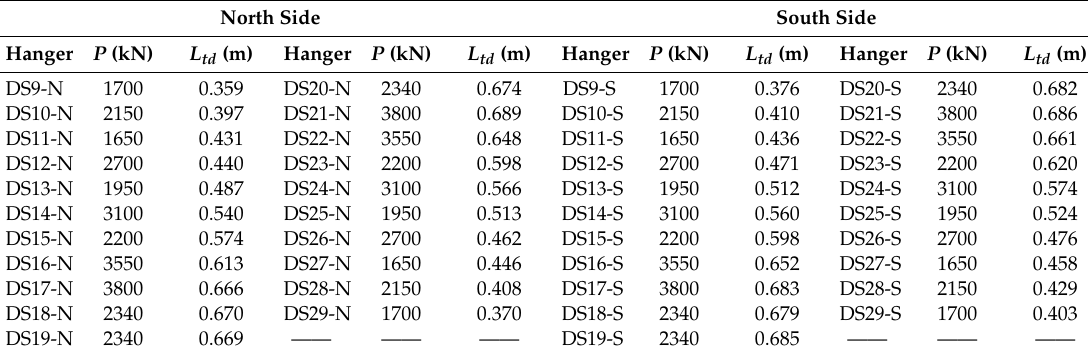
Table 5. Target values of the control parameters of tensioning round 2.